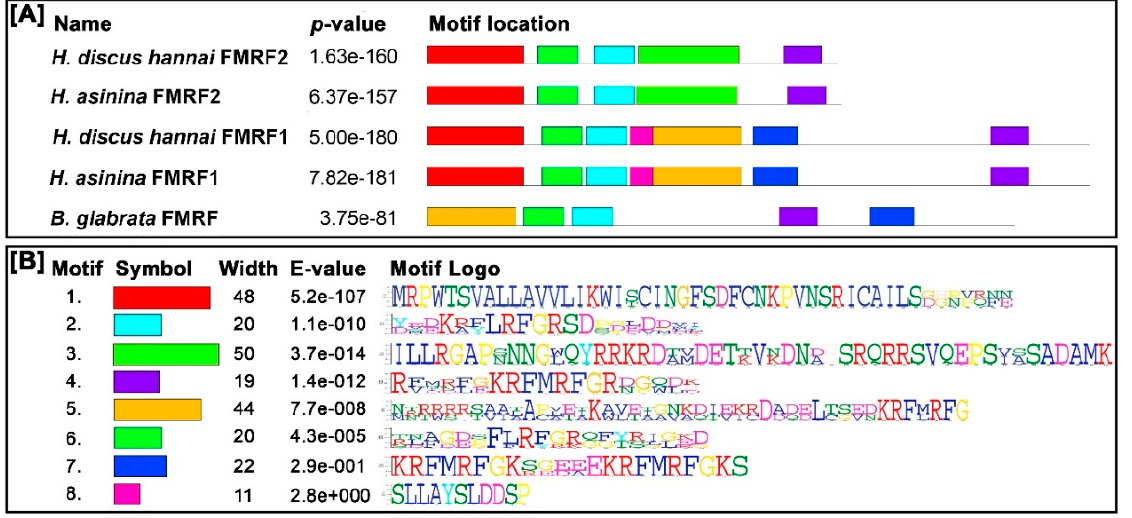
Figure 3. Conserved motif analysis of FMRFamide proteins. ( A ) Schematic diagram of distribution of motifs in FMRFamide peptides (details of sequences are presented in Supplementary Table S3). The black solid line represents the length of corresponding FMRFamide protein. Different colored boxes indicate different motifs and their position in each FMRFamide sequence. ( B ) Sequence logo of the FMRFamide motif determined through MEME analysis. The motif logo contains stacks of letters at each position in the motif bits. The height of the individual letters in a stack is the probability of the letter at that position multiplied by the total information content of the stack. The E-value is an estimate of the expected number of motifs that one would find in a similarly sized set of random sequences. The number of widths is the number of amino acids in the respective motif.